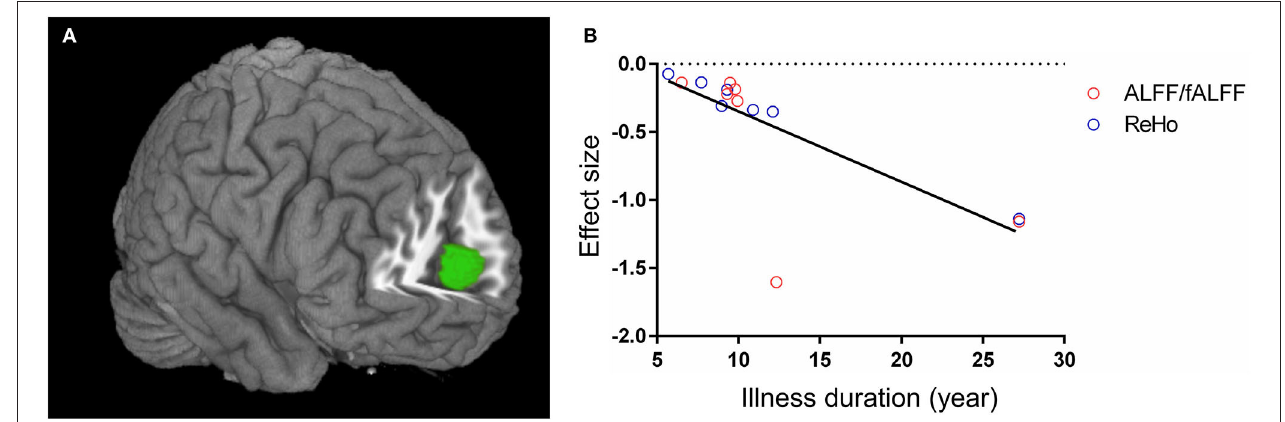
FIGURE 3 | Metaregression analysis results. (A) The illness duration of patients with type 2 diabetes mellitus was negatively associated with regional activity in right anterior cingulate/paracingulate gyri, extending to bilateral medial superior frontal gyrus and left anterior cingulate/paracingulate gyri. (B) The effect sizes needed to create this plot were extracted from the peak voxel of maximum slope difference. The ALFF/fALFF and ReHo studies are represented as red and blue empty circles, respectively. The regression line (metaregression SDM slope) is presented as a straight line. ALFF, amplitude of low-frequency fluctuations; fALFF, fractional ALFF; ReHo, regional homogeneity; SDM, seed-based d